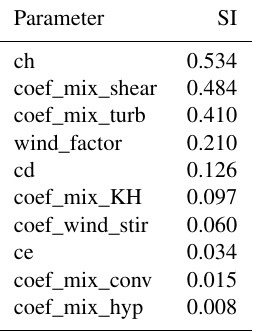
Table 1. Values of sensitivity index (SI) for lake Ammersee water temperature